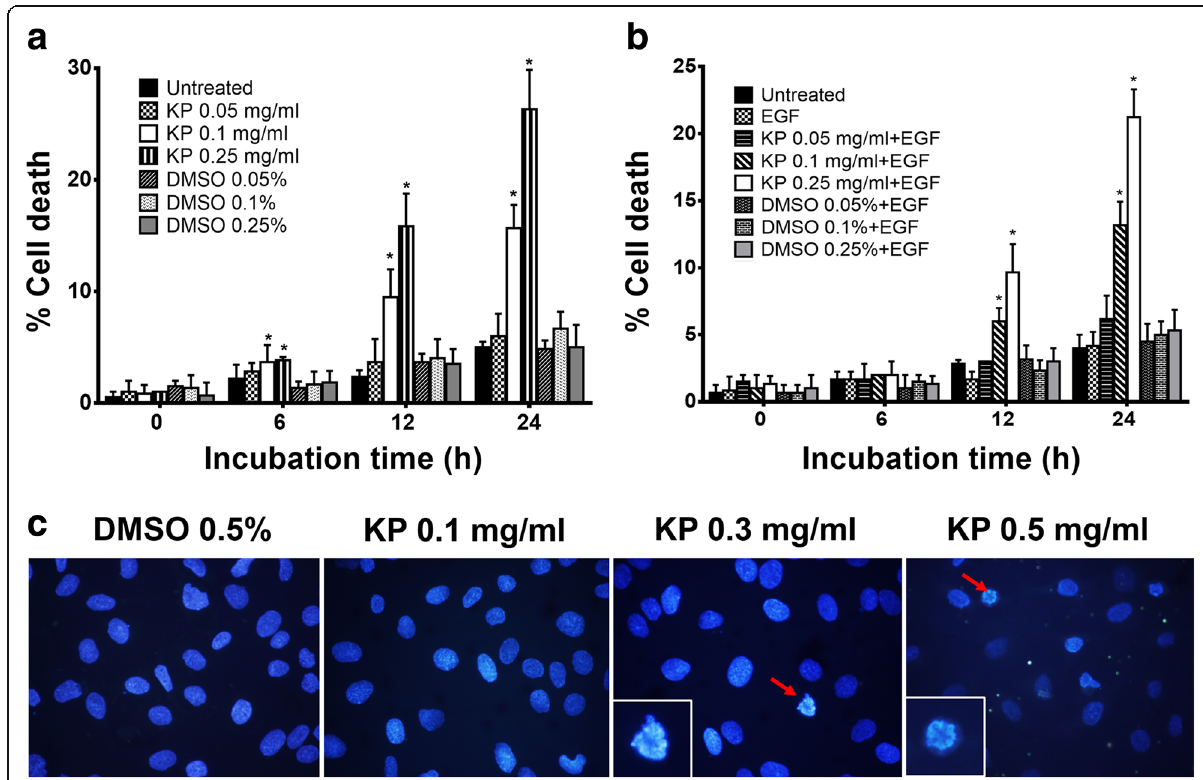
Fig. 6 The effect of KP on cell death in SKOV3 cells by trypan blue exclusion assay. Percent of cell death of cells treated with KP without EGF ( a ) and with 100 ng/mL EGF ( b ). Data presented as means ± SD, n = 3, * P < 0.05 compared to DMSO control. The DNA staining (Hoechst 33342) of KP treated cells shows nuclear deformity ( c ). The condensation of the nucleus was observed in KP ethanol extract treatments compared to the vehicle control DMSO. Original magnification,